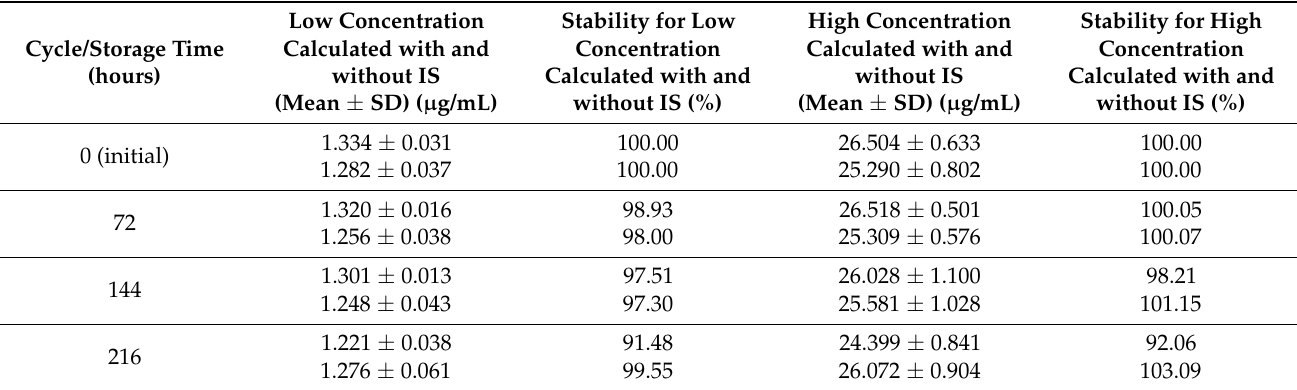
Table 3. Freeze-thaw stability ( n = 3).